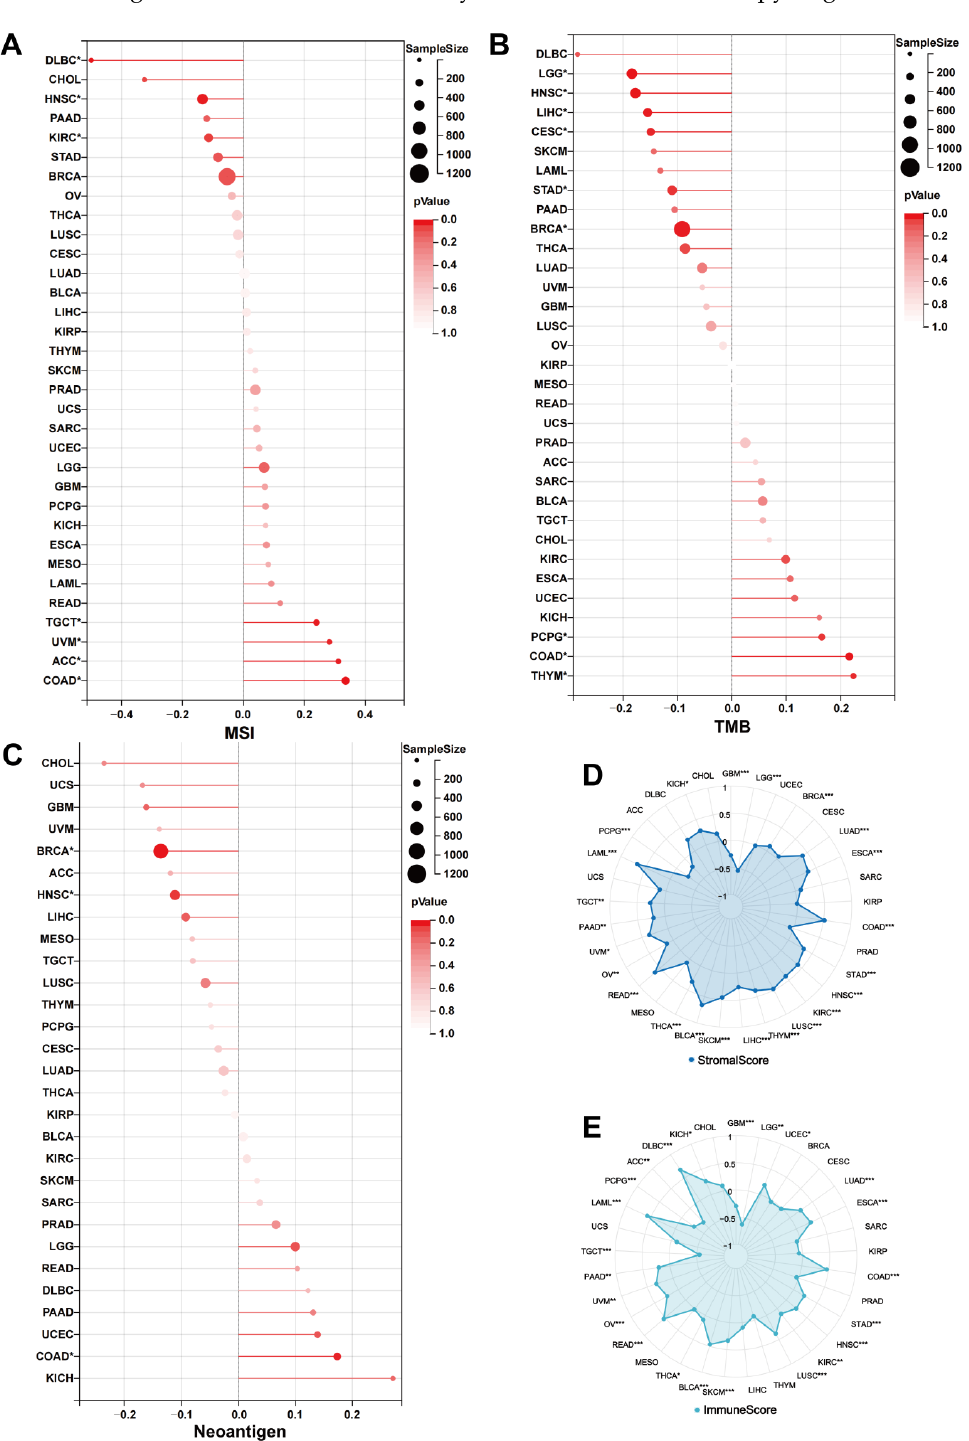
Figure 8. The relationship between UNC5A expression and TMB, MSI, neoantigen, and TME in pan-cancer. ( A ) The association between UNC5A expression and MSI across cancer types. ( B ) The association between UNC5A expression and TMB in pan-cancer. ( C ) The relationship between UNC5A expression and neoantigen across cancer types. ( D , E ) The relationship between UNC5A expression and StromalScore and ImmuneScore in pan-cancer. * p < 0.05, ** p < 0.01, *** p <